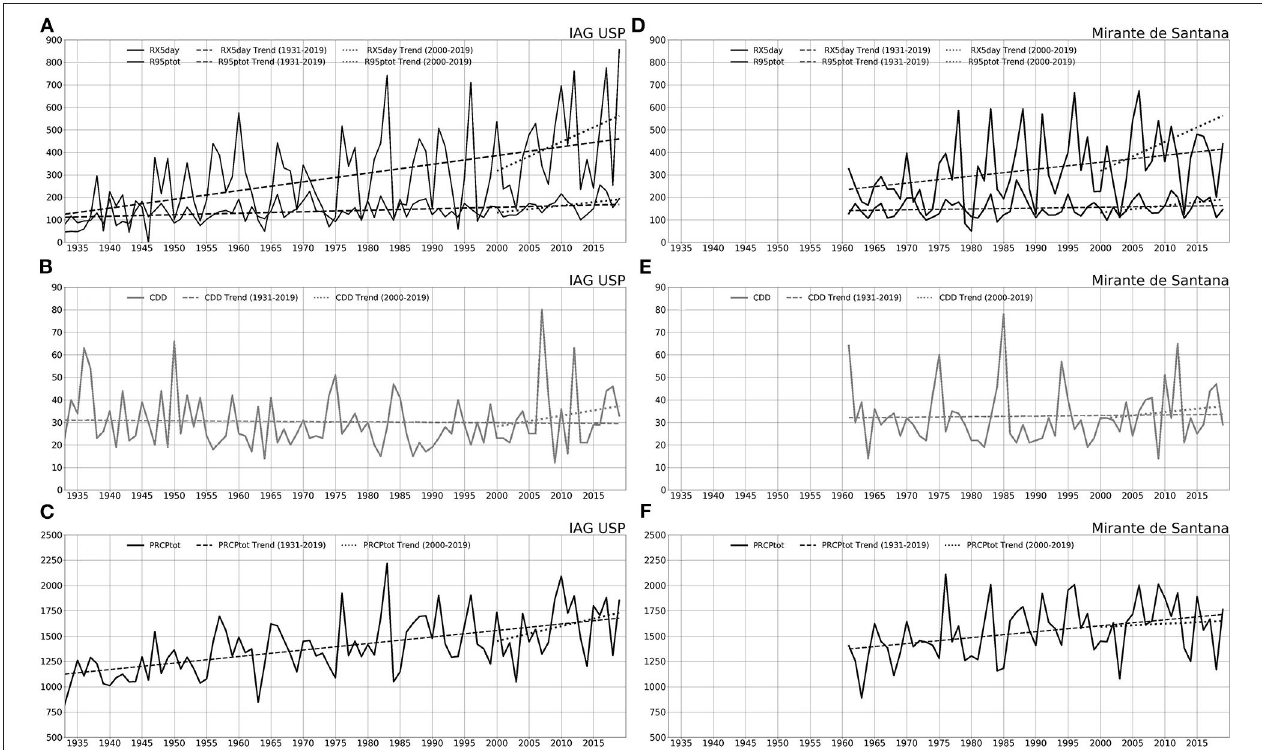
FIGURE 2 | Time series of heavy precipitation (R95P); 5 days accumulated precipitation (R5xD); consecutive dry days (CDD) and total annual precipitation (PRECTOT) during 1931–2019 for IAG-USP (A–C) and Mirante de Santana during 1961–2019 (D–F) . Linear trends are shown with full (since 1961) and broken (2000–2019)